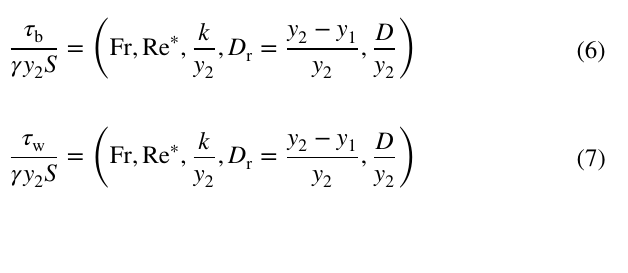
Fig. 4 The variation of mean velocity of flow in smooth compound channel a Q 1 , b Q 2 and c Q 3